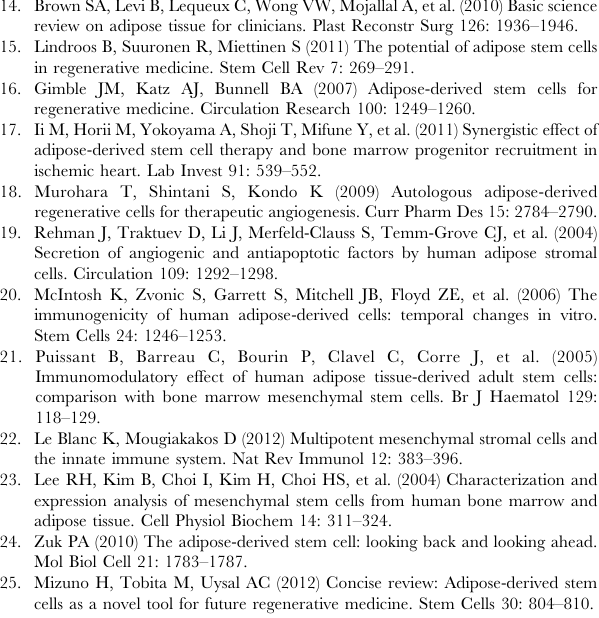
Figure S4 Histological quantification of ASCs treated wounds. 1 6 10 5 ASCs were delivered to 7 mm wounds on one ear and 3 6 10 4 ASCs were delivered to wounds on the contralateral ear of rabbits. Wounds were harvested at POD7 and epithelial gap (A) and granulation tissue area (B) were measured (n= 11 for 1 6 10 5 ASCs & n = 12 for 3 6 10 4 ASCs). N represents the total number of wounds from two rabbits. Data shown as mean + SEM. ns=not significant. (PDF) Figure S5 Measurement of epithelial gap of ASCs treated wounds. A total of 1 6 10 5 ASCs were delivered to 7 mm wounds on one ear. In the contralateral ear, PBS alone was delivered as a control. Wounds were harvested at POD7 and epithelial gap was measured. Data shown as mean + SEM. n= 35 for saline & n= 36 for ASCs. N represents the total number of wounds from six rabbits. ns =not significant. (PDF) Figure S6 Comparison of the effect of ASCs, BM-MSCs, and DFs on wound repair. The granulation tissue measure- ment data at POD7 wounds in Figure 3 was re-analyzed by the ANOVA with post-hoc analysis. Number of wounds analyzed; n =69 for saline, n= 20 for BM-MSCs, n= 36 for ASCs, n= 24 for DFs. N represents the total number of wounds from fourteen (saline), six (ASCs), or four (DFs & DM-MSCs) rabbits. Data shown as mean + SEM. *p , 0.05, **p , 0.01. (PDF) Figure S7 Analysis of a -SMA expressing cells in wounds. Chicken anti-GFP and mouse anti- a -SMA antibodies were used to detect GFP and a -SMA. Nuclei were stained with DAPI. GFP (A, D, G), a -SMA (B, E, H), and merged (C, F, I) images in Figure 4E, 4F, 4G were shown. Endogenous cells and transplanted ASCs which express a -SMA showed red and yellow color, respectively, in the merged images (C, F, I). Transplanted ASCs which do not express a -SMA showed green color in the merged images. Scale bars: 50 m m. (PDF)